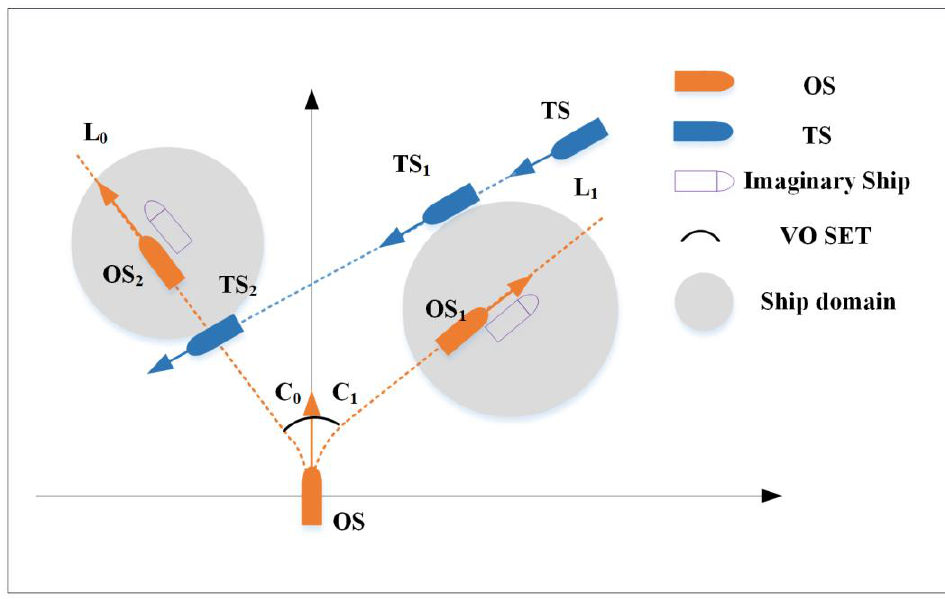
Figure 6. Feasible manoeuvring decision interval.